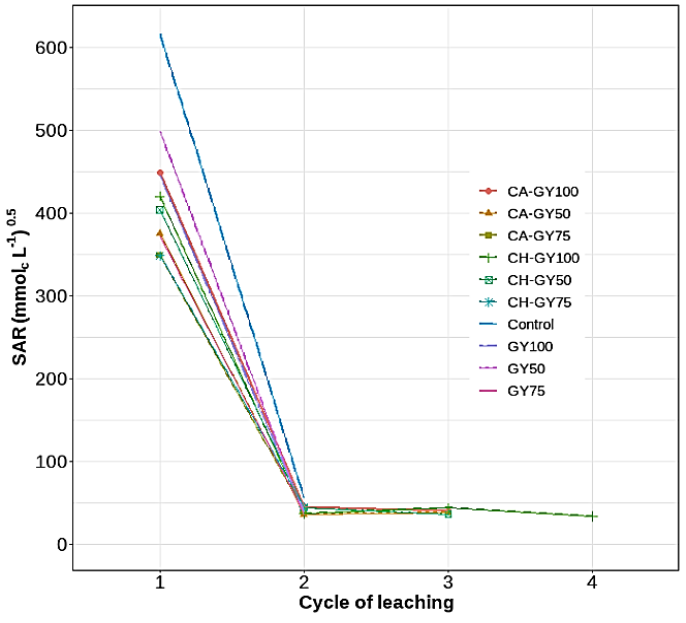
Figure A1. Evolution of sodium adsorption ratio (SAR) in the leachates at each cycle of leaching.